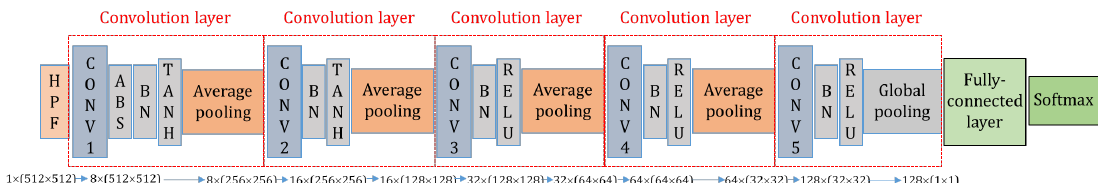
Figure 4. Initial CNN for image steganalysis [17]. The CNN extracts 128 1 × 1 feature maps from a 512 × 512 input image.